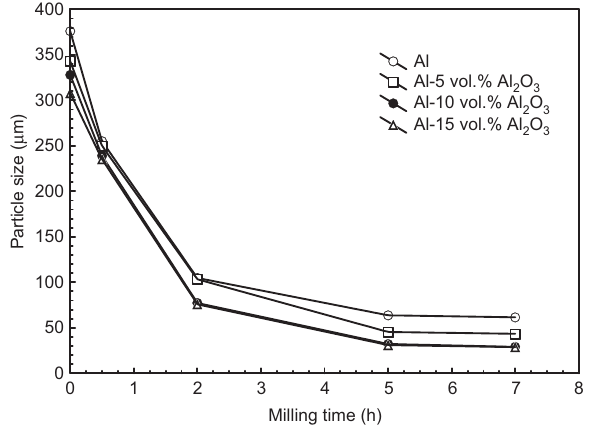
Figure 2 The effect of milling time on the average particle size of monolithic Al and Al-Al